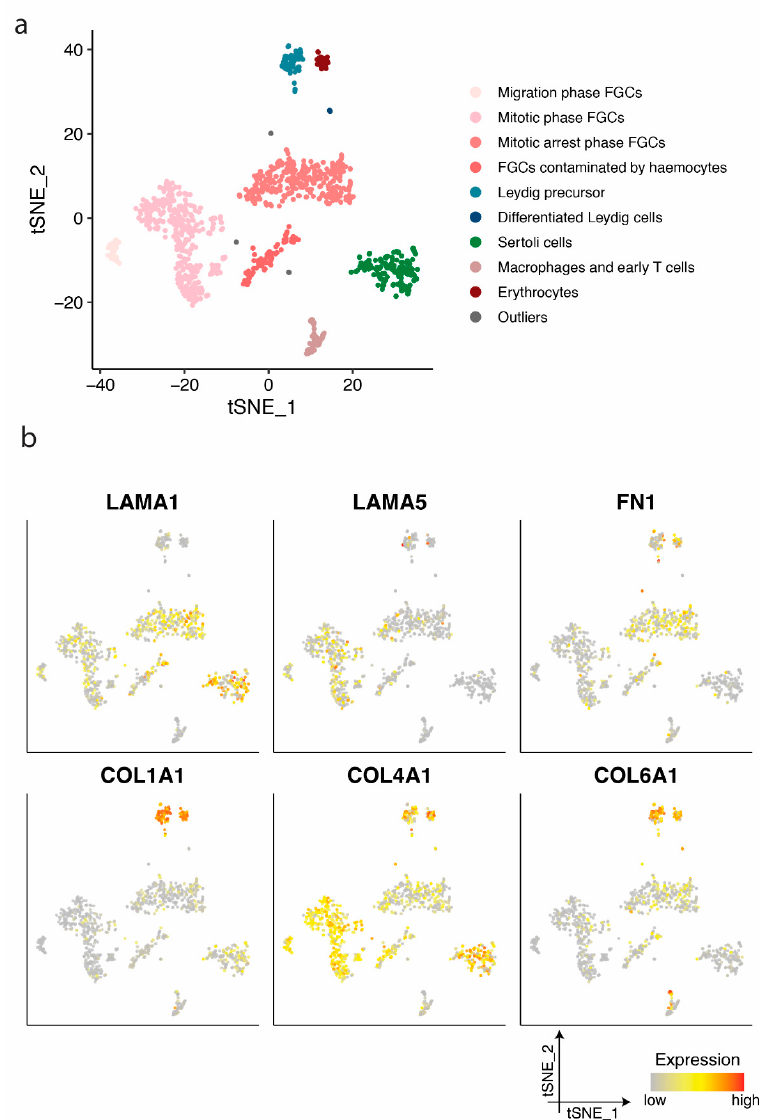
Figure 2. Identification of cell clusters and single-cell transcription profiles of prenatal gonadal cells. ( a ) The t-distributed stochastic neighbour embedding (t-SNE) plot of germ and somatic cells, coloured by the identified cell types. FGC indicates foetal germ cells. ( b ) Single-cell expression profile for extra cellular matrix (ECM) protein coding genes exhibited on the t-SNE plot; gradient of grey, yellow, orange, and red indicates low to high expression.